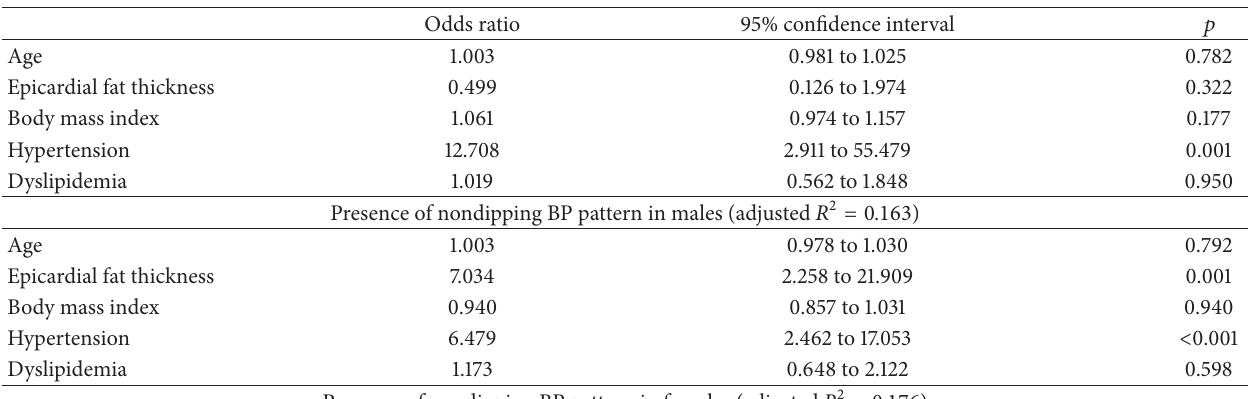
Table 8: Binary logistic regression analysis to identify the independent determinants of nocturnal nondipping blood pressure (BP)